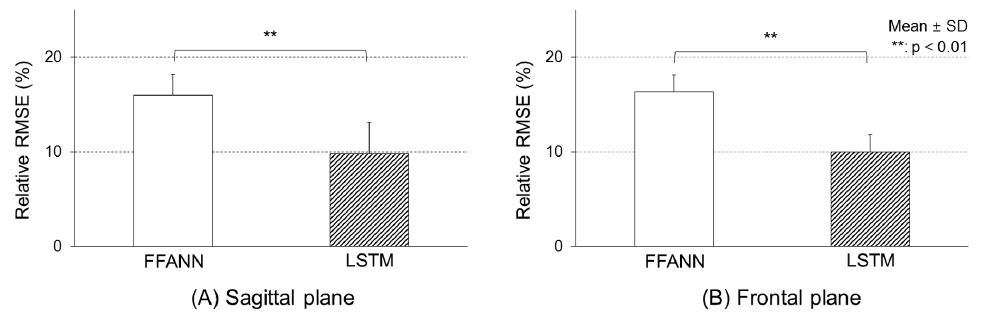
Figure 6. Relative RMSE values between the calculated and predicted COM-COP IAs.